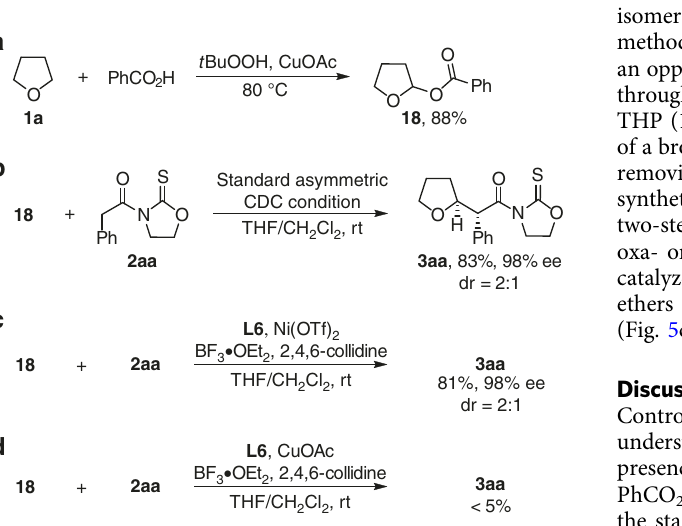
Fig. 6 Mechanistic studies. a Reaction intermediate identi fi cation. b Asymmetric coupling of 18 with 2aa. c Asymmetric coupling of 18 with 2aa in the absence of CuOAc. d Identi fi cation of the real metal catalyst for the asymmetric